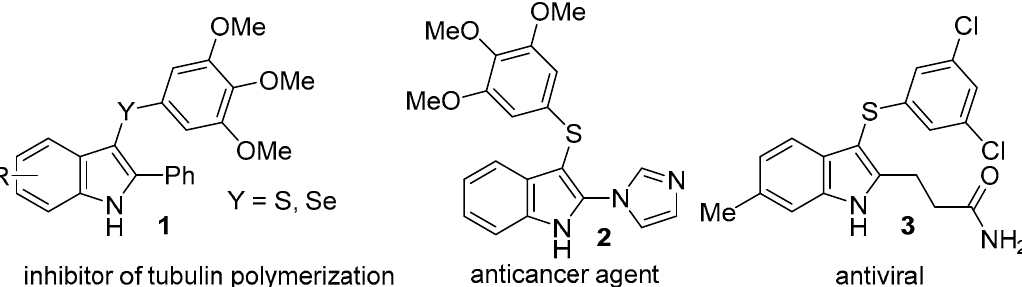
Figure 1. Selected examples of biologically active 3-selanyl- and 3-sulfanylindole compounds. However, these strategies suffer from limitations, such as the need for